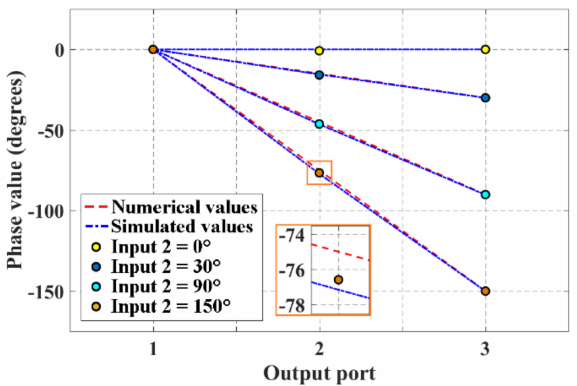
Figure 7. Phase values obtained by measurements and full-wave simulation for the block of 2 × 3 CORPS network.